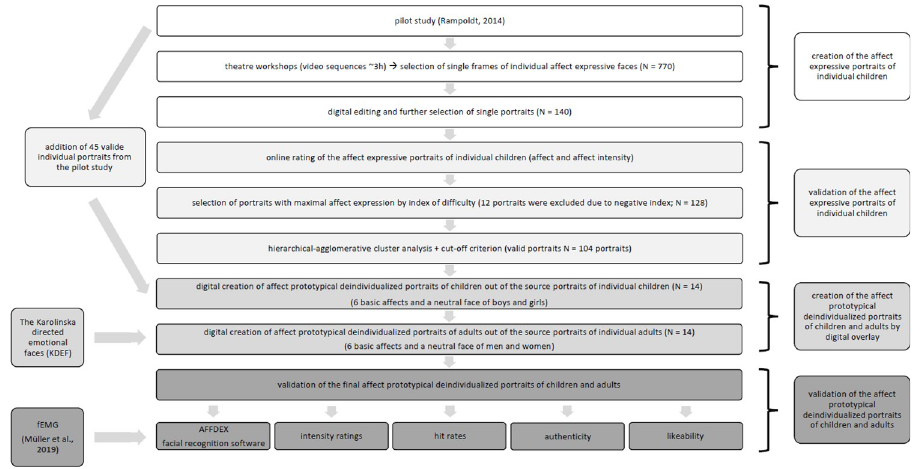
Fig 1. Procedure of the present